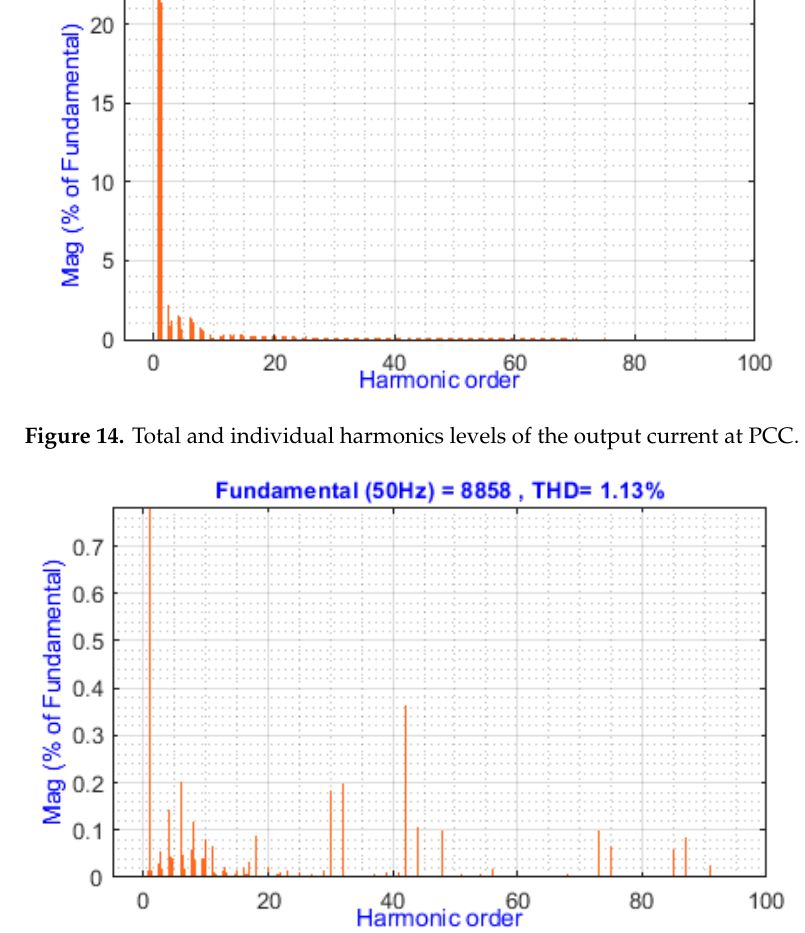
Figure 15. Total and individual harmonics level of the output voltage at PCC after filtering.